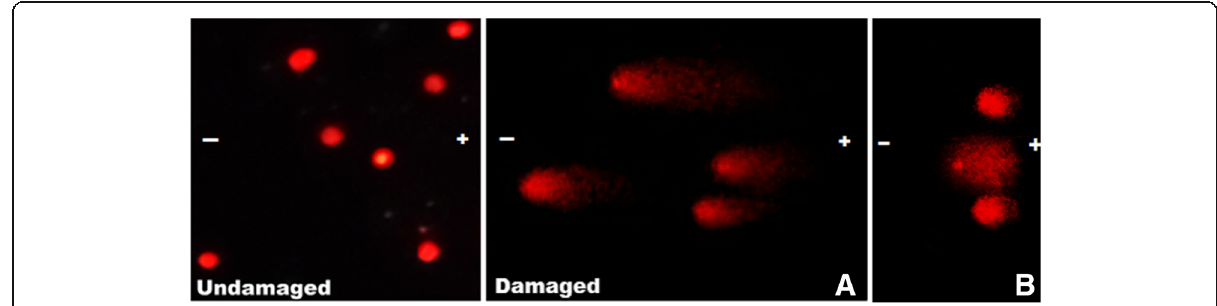
Fig. 26 Sperms DNA in control (undamaged) and after CCl4 treatment (Damaged ( a )) and CCL4 with NAC ( b